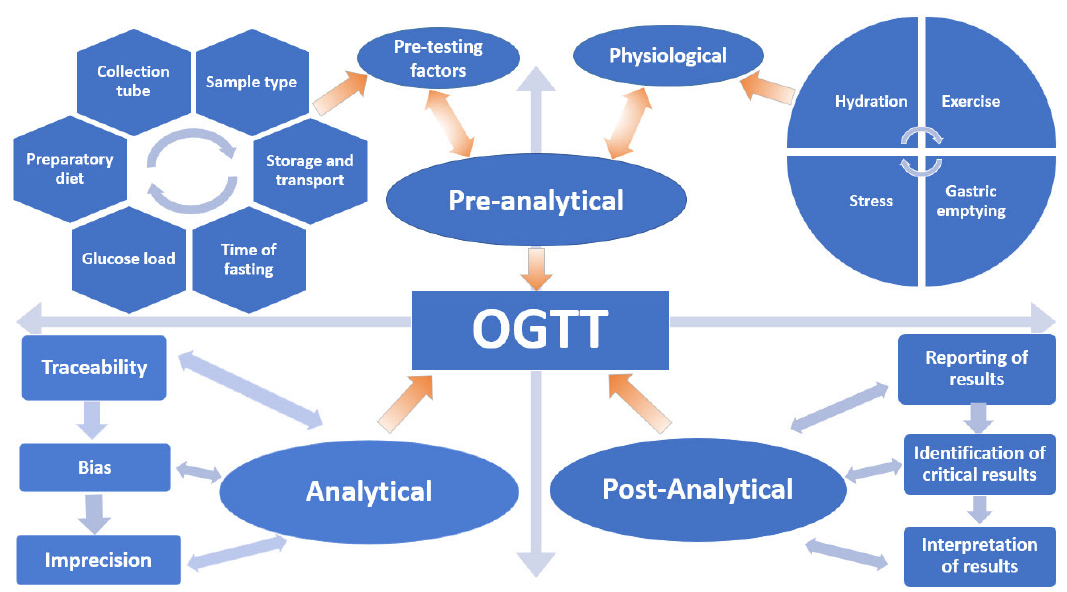
Figure 1. Variables that influence the oral glucose tolerance test (OGTT).